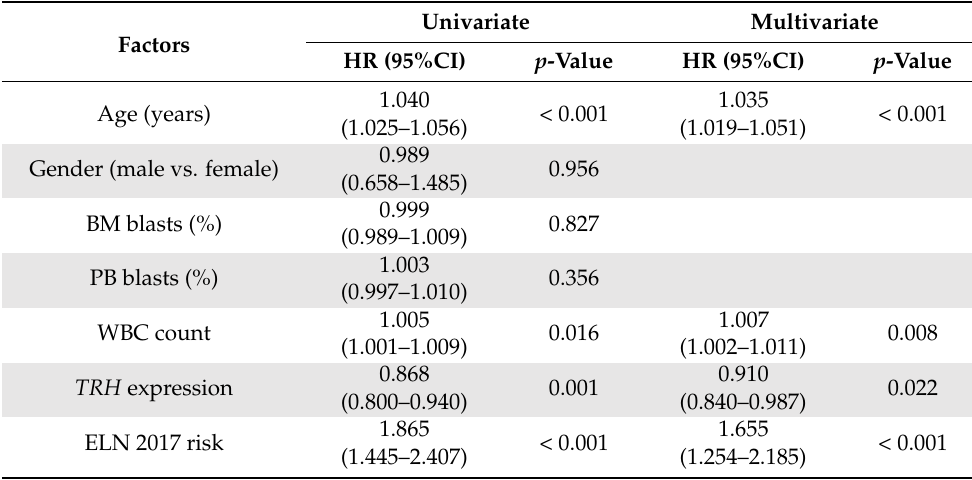
Figure 6. Improvement of the ELN 2017 risk system with TRH expression. ( a ) Comparison of TRH expression in different cytogenetic subgroups of TCGA AML according to the ELN 2017 risk system. ( b ) Comparison of TRH expression in different cytogenetic subgroups of GSE6891 dataset. Statistical significance was determined using the Wilcoxon test. ( c ) Kaplan–Meier plots of patients with high- and low- TRH expression in different risk groups of TCGA AML. Log-rank tests were used to compare the differences. Table 1. Uni- and multi-variate Cox regression analysis for overall survival of TCGA AML.